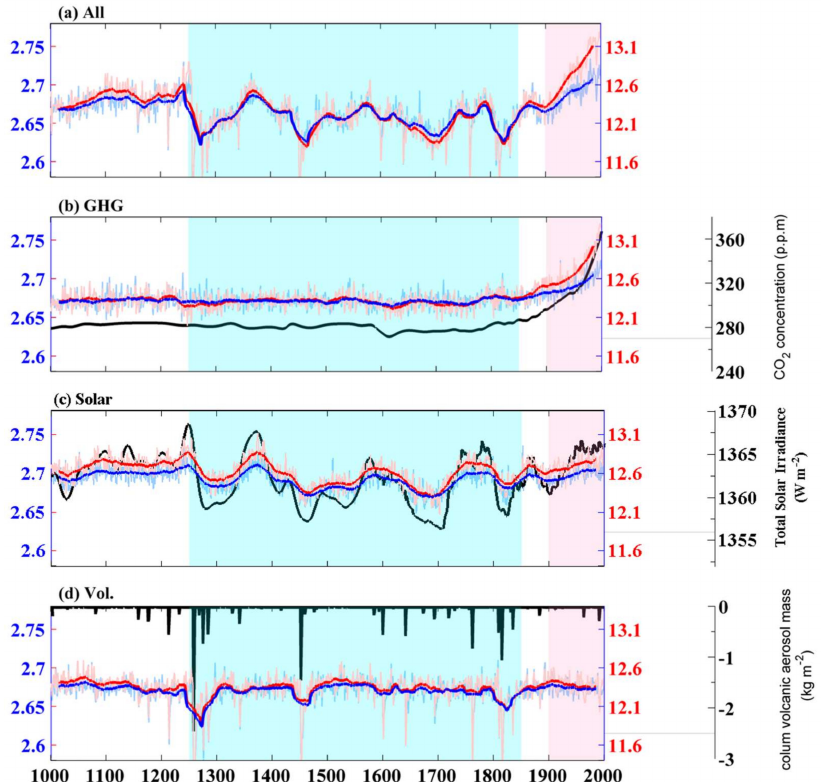
Figure 1. Responses to different external forcing. Shown are the 31-year running-mean time series of external forcing (thick black curve in b – d ) and simulated global-mean surface temperature (thick red curve) and global-mean precipitation (thick blue curve) under ( a ) all-four forcing; ( b ) greenhouse gas (GHG) forcing; ( c ) solar forcing; and ( d ) volcanic forcing. The annual-mean global-mean surface temperature (thin red curve), global mean precipitation (thin blue curve) and two typical periods (1250–1850 for Little Ice Age (LIA), pale blue shade and 1900–2000 for Present Warm Period (PWP), lavender shade) are also